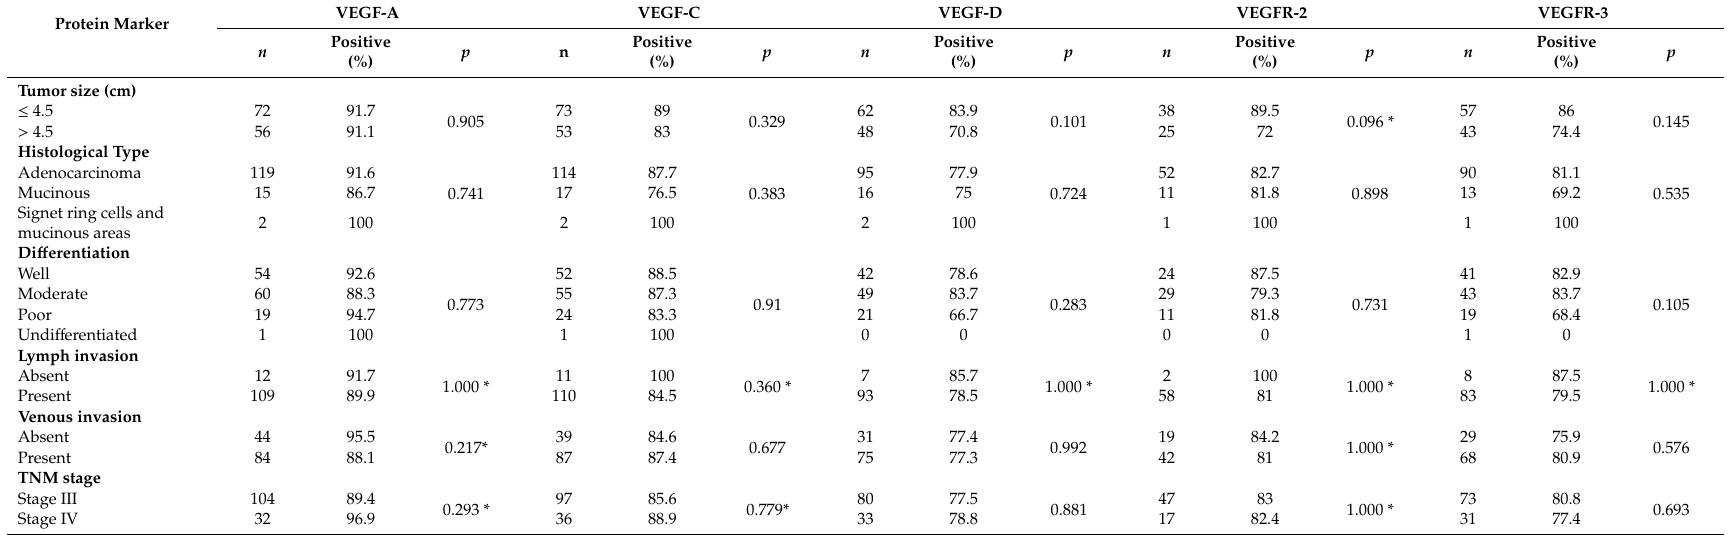
Table 5. Assessment of correlation between CRC lymph node metastasis VEGF-A, VEGF-C, VEGF-D, VEGFR-2 and VEGFR-3 pathological data. * Examined for statistical significance using Fisher’s exact test (when n <